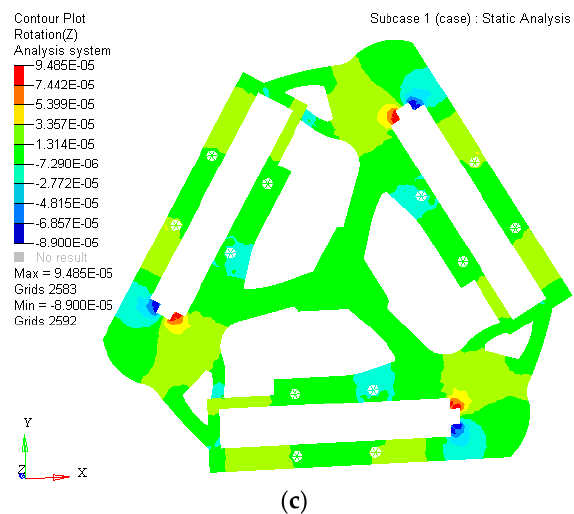
Figure 8. The kinematostatic characteristics of optimized material structure ( a ) the displacement of optimized material structure with direction x ; ( b ) the displacement of optimized material structure with direction y ; ( c ) the displacement of optimized material structure with rotational directional z .